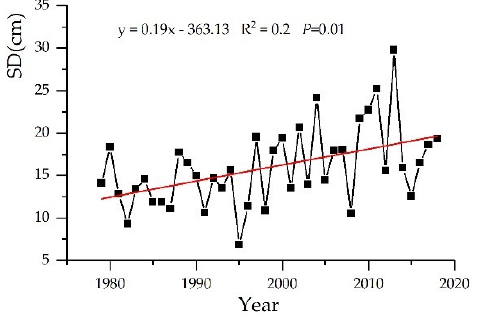
Figure 10. Interannual variation in mean snow depth during the period of 1979–2018.